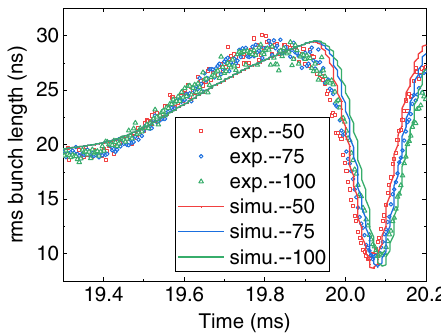
FIG. 9. Measured and simulated evolution of bunch length during the bunch stretching and bunch rotation for three rf voltage rise times of 50, 75, and 100 μ